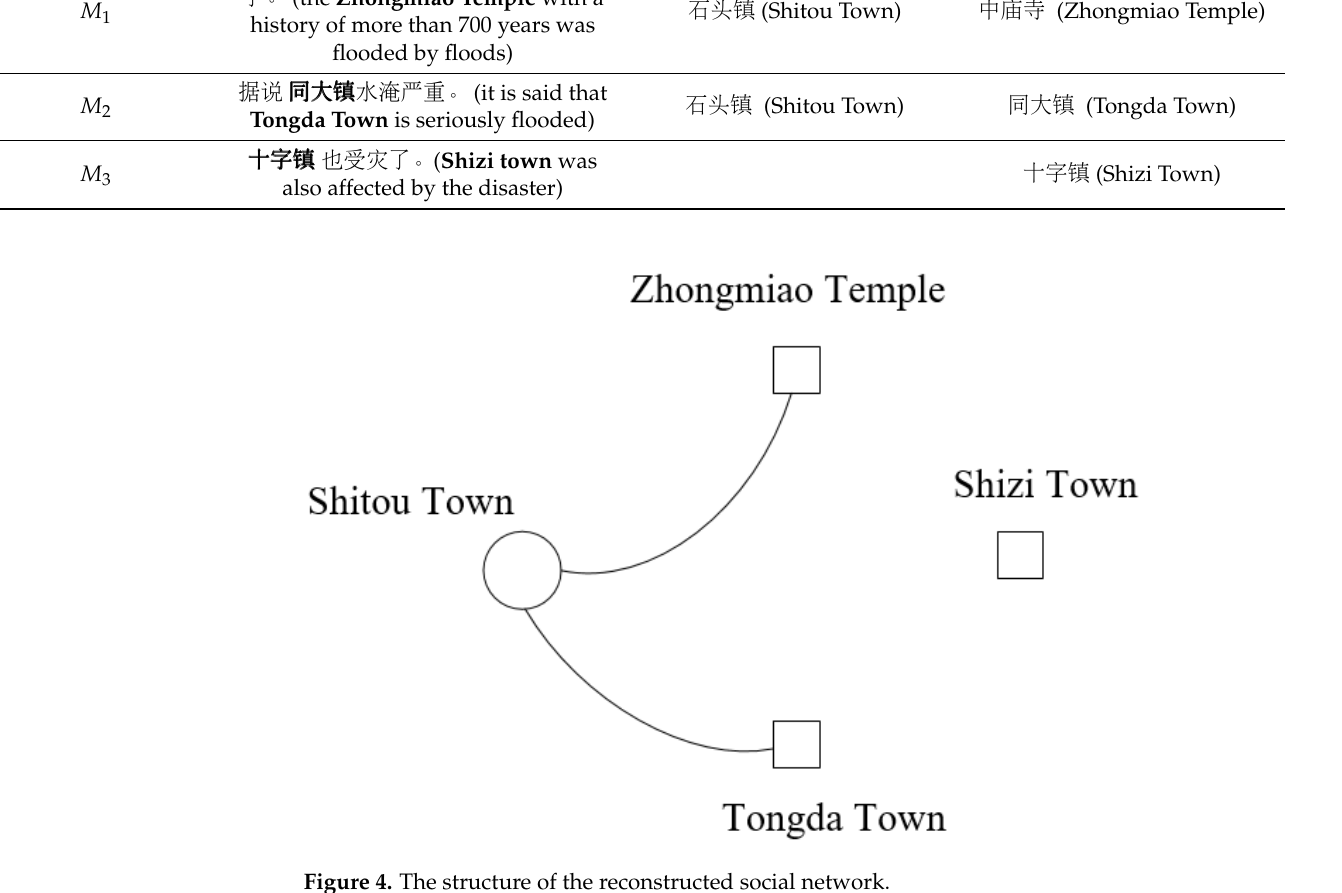
Figure 4. The structure of the reconstructed social network.